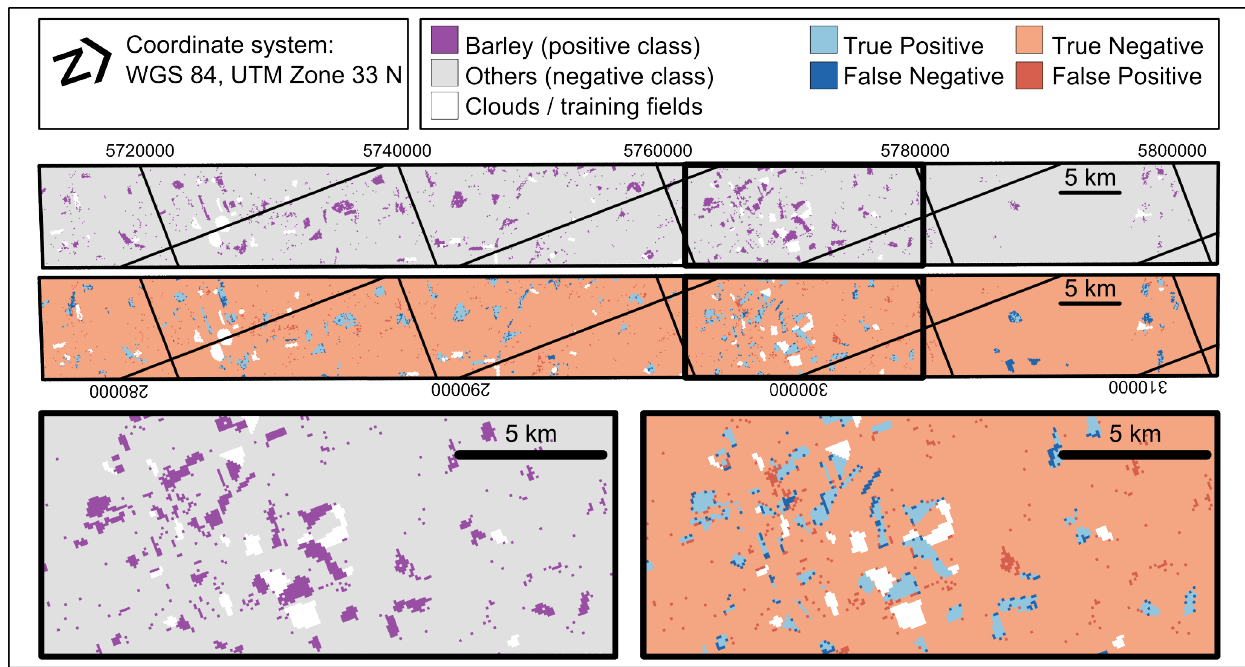
Figure 7. Classification and test errors for the class barley realized with the manually selected model and the threshold ˆ θ MAP (see Figure 6 and Table